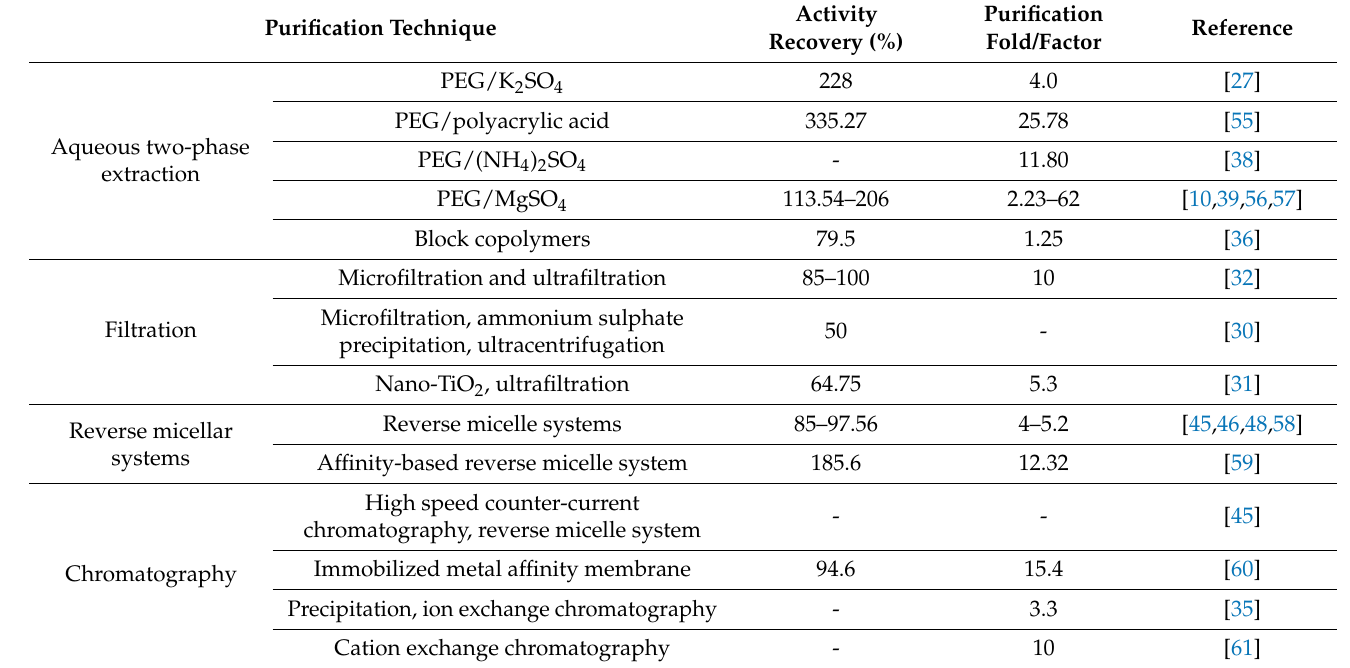
Table 2. Unconventional techniques for the extraction and purification of bromelain (adapted from Manzoor et al., 2016 [54]). Purification Technique